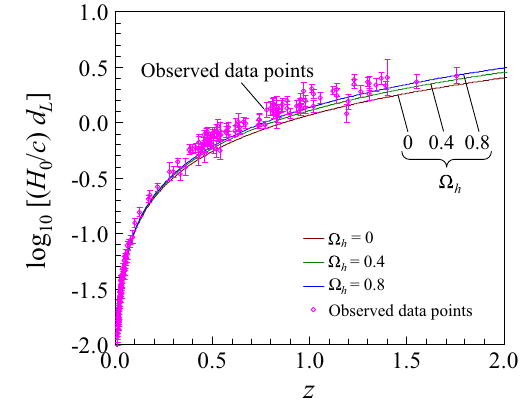
Fig. 3 Dependence of the temporal deceleration parameter q on red- shift z . The solid lines represent q for the present model, while the symbols represent q for the (cid:2) CDM model. Note that positive q repre- sents deceleration and negative q represents acceleration